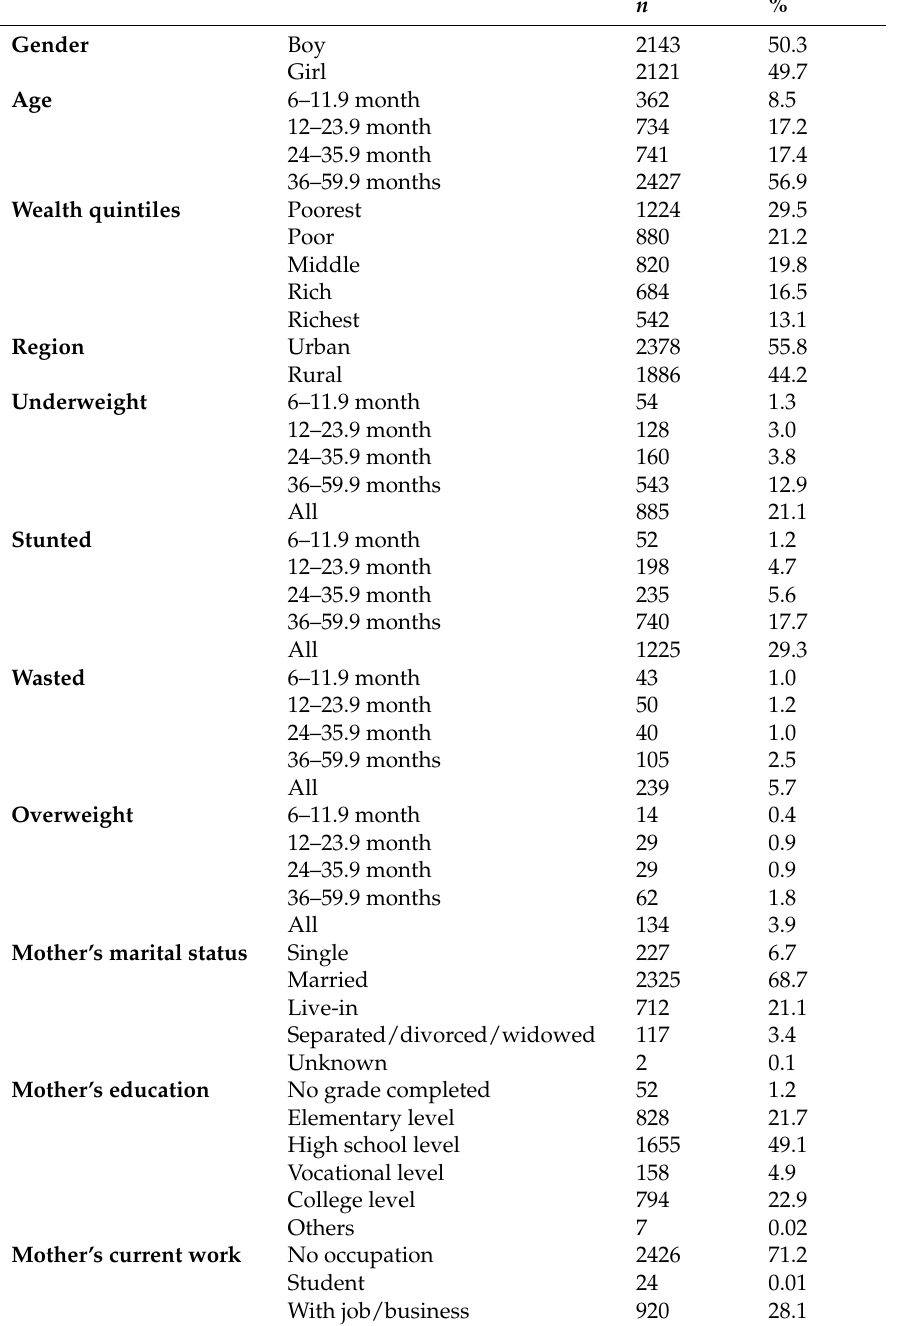
Table 2. Characteristics of the study